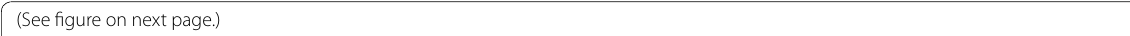
Fig. 3 Morphological comparison of bacteria treated with M. minuta leaves extract by scanning electron micrograph. Arrows indicates swollen cells, leakage of cell contents and change in cell shape. A1— Pseudomonas aeruginosa (Control); A2— Pseudomonas aeruginosa (Treatment); B1— Klebsiella pneumonia (Control); B2— Klebsiella pneumonia (Treatment); C1— Enterococcus faecalis (Control); C2— Enterococcus faecalis (Treatment); D1— Bacillus subtilis (Control); D2— Bacillus